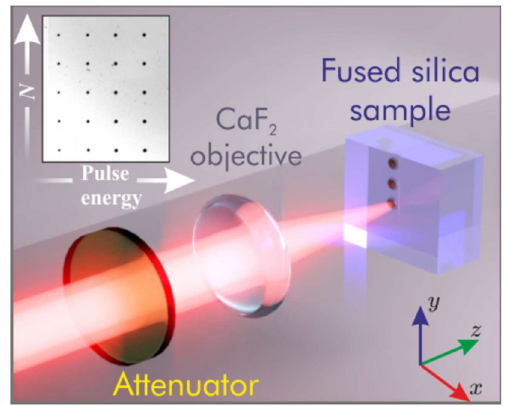
Figure 1. Sketch of the experimental setup employed for LIPSS formation on fused silica. The inset shows optical microscope image of the array of damage structures produced by varying energy and number of successive